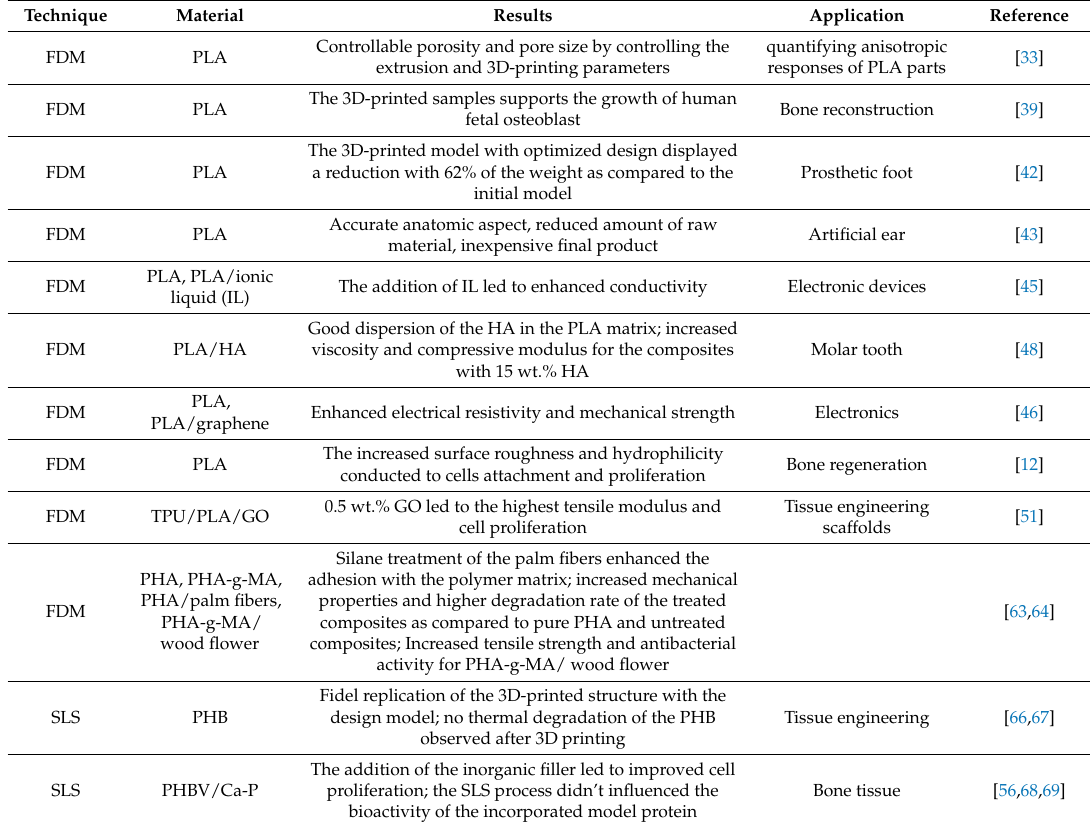
Table 3. Summary of 3D-printed PLA-based